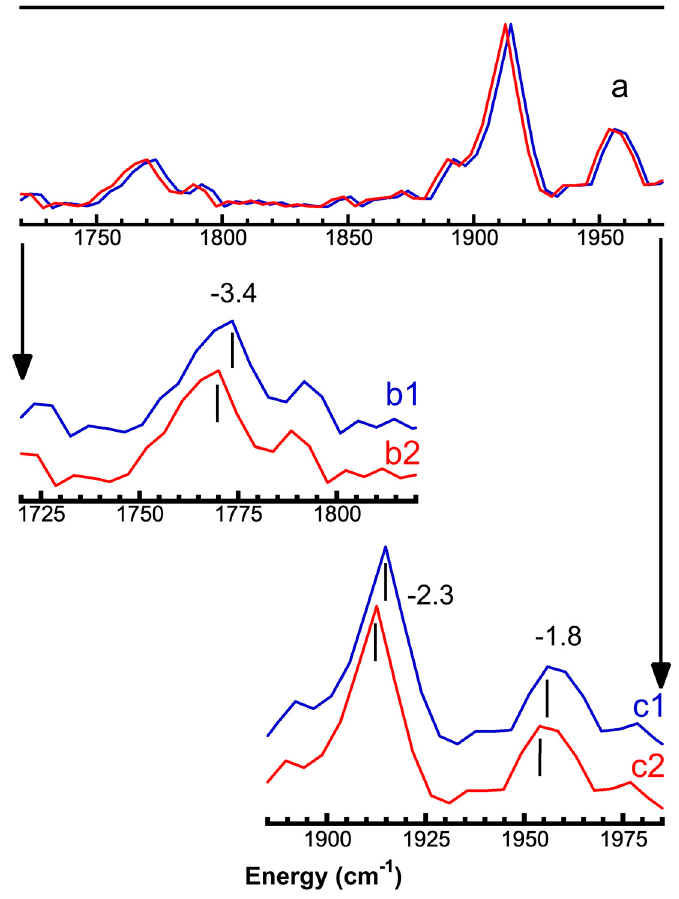
Figure 5. ( a ) NRVS PVDOS of complex trans − [ 57 Fe( η 2 − H 2 )(H)(dppe) 2 ][BPh 4 ] (H 2 FeH for short) in the region for Fe–H stretching modes calibrated with the traditional procedure (1) (blue) and with new time-scaled redistribution method (2) (red); ( b ) PVDOS for ( a ) in the narrower region of 1720 − 1820 cm − 1 ; and ( c ) PVDOS for ( a ) in the narrower region of 1885–1985 cm − 1 .